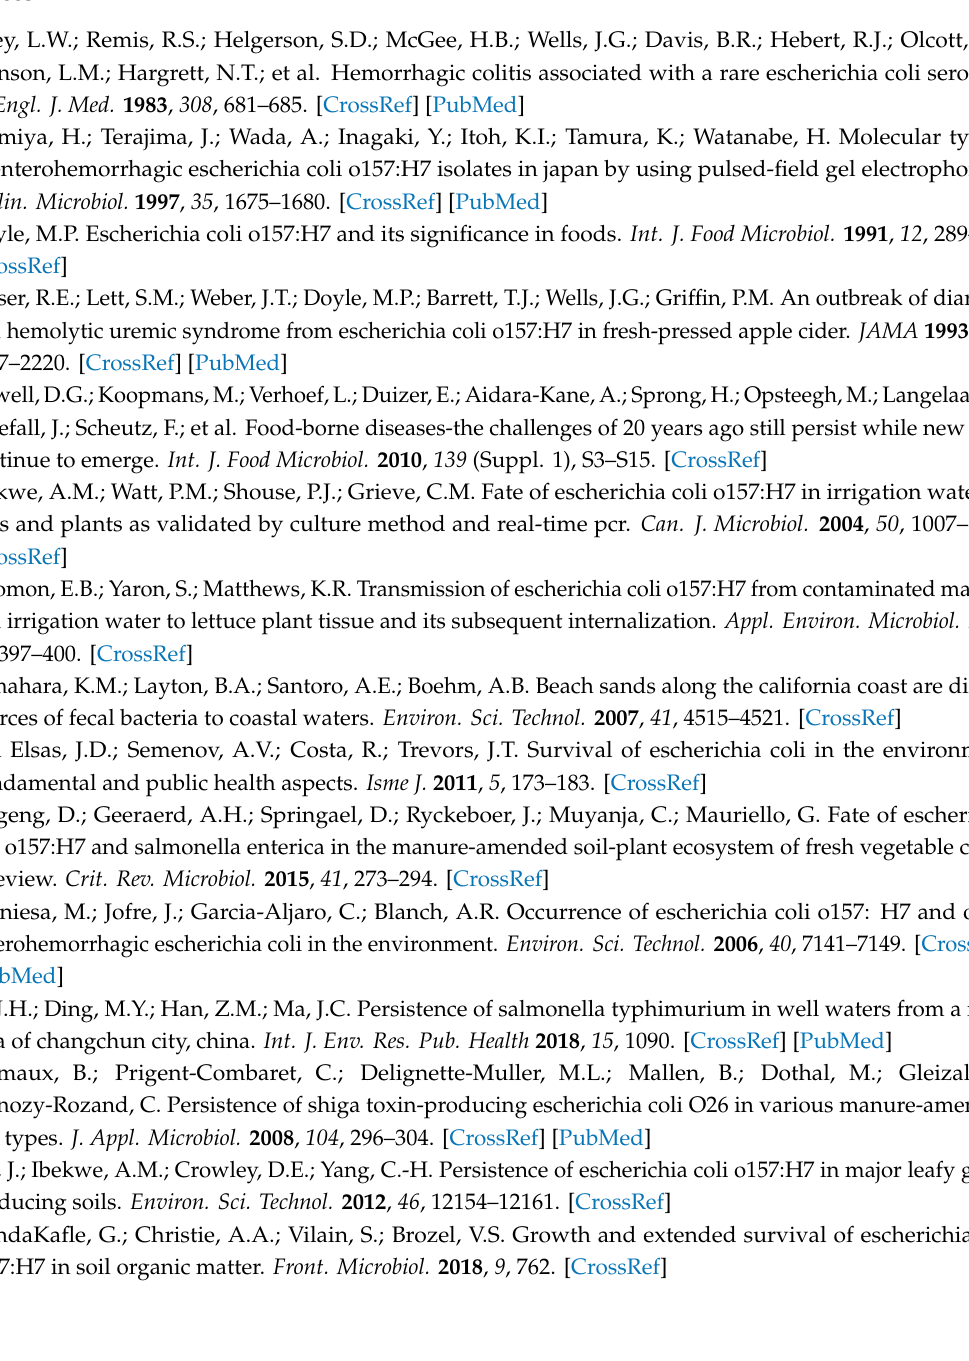
Table S1: Results of soil physical and chemical